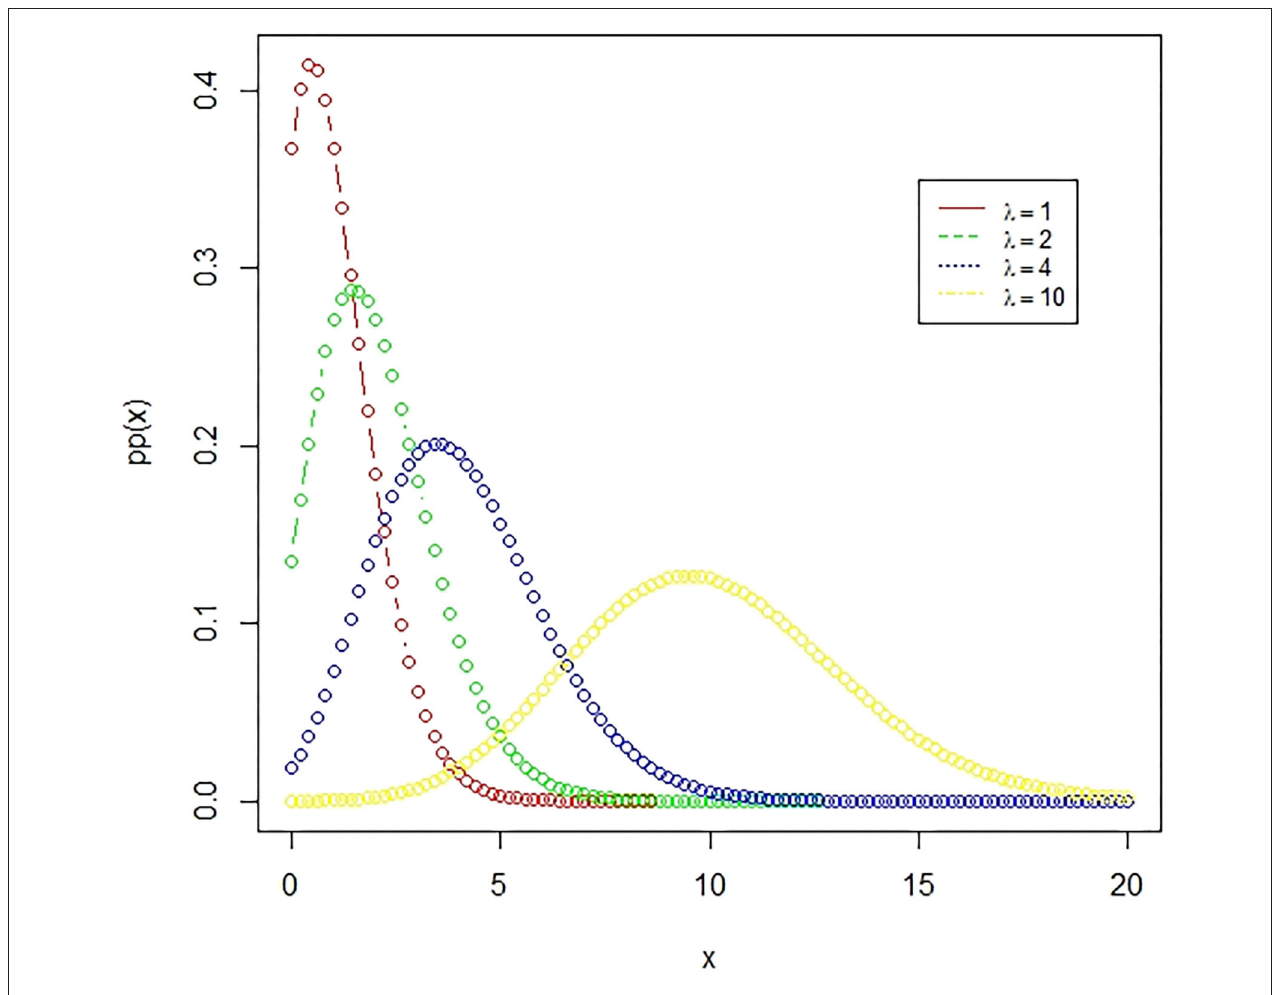
FIGURE 3 | The Poisson distribution. A Poisson distribution represents the probability of happening of rare events, where the number of favorable outcomes is very low in comparison to the total events. The presented figure represents different Poisson curves for different values of the